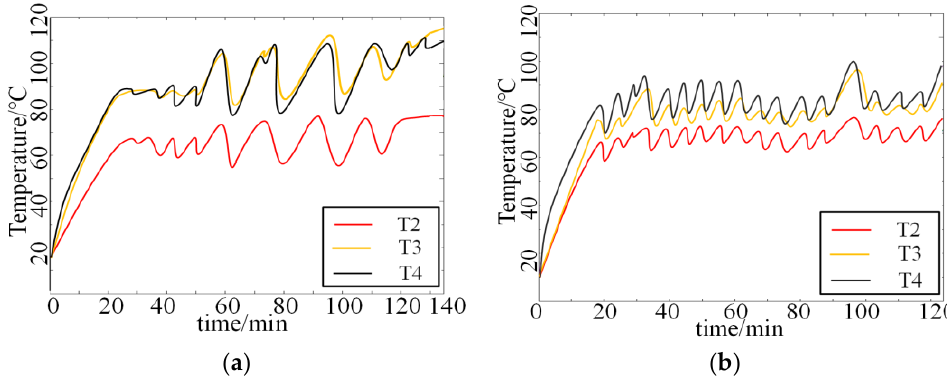
Figure 5. Temperature profile for heat flow density of 2667~3111 W·m 2 at an inclination angle of − 2 , ( b ) q = 3111 W · m − 2 90°. ( a ) q = 2667 W·m −2 , ( b ) q = 3111 W·m −2 . ( a ) q = 2667 W · m